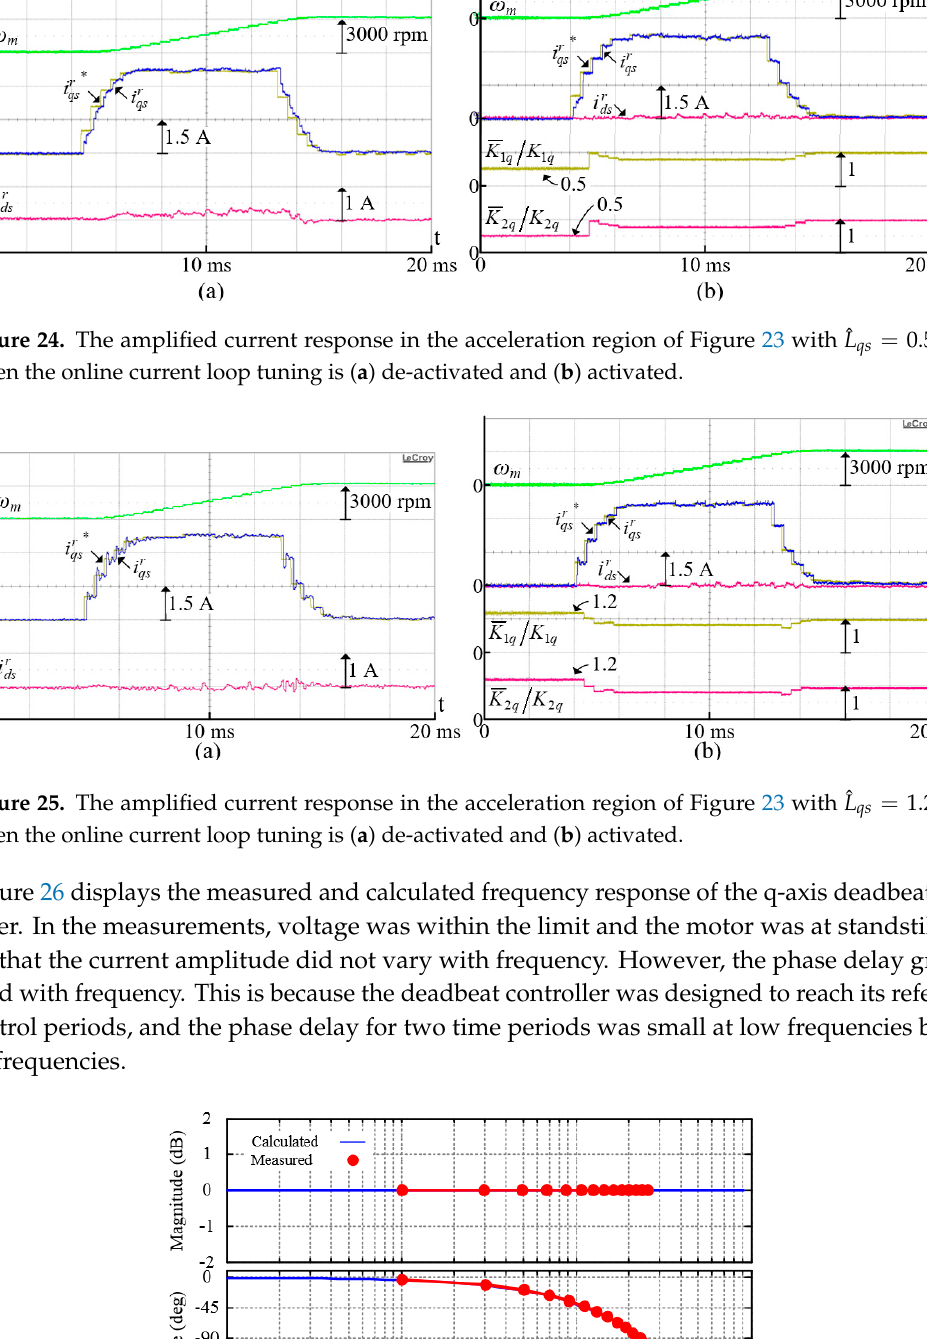
Figure 23. The amplified current response in the acceleration region of Figure 23 with qsqs LL = ˆ when the online current loop tuning is ( a ) de-activated and ( b ) activated.